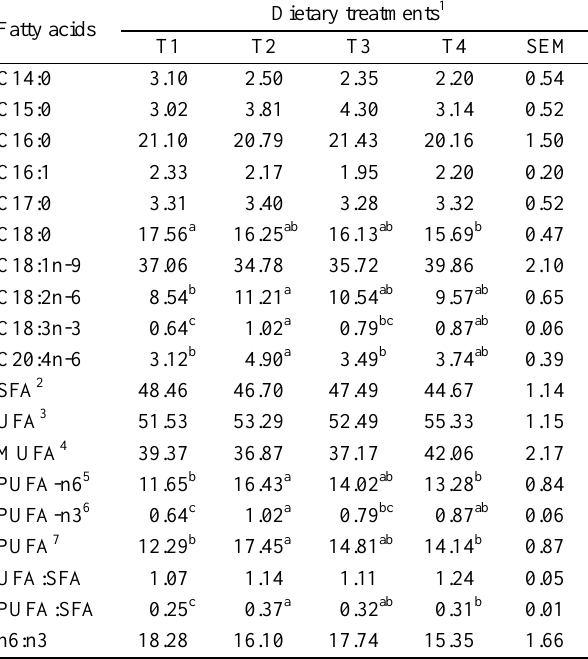
Table 4. Fatty acid composition (% of total identified fatty acids) of the intramuscular fat from the longissimus lumborum muscle in goats fed experimental diets Fatty